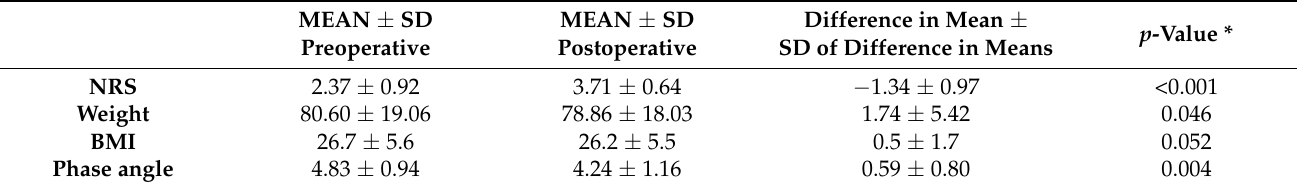
Table 2. Comparison between pre- and postoperative parameters of the Intervention